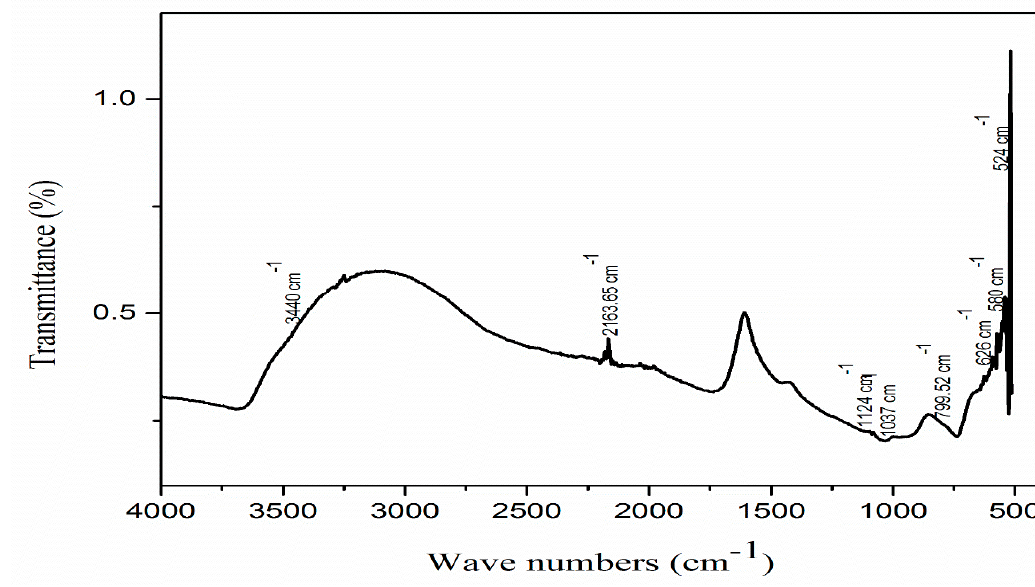
8 of 20 Figure 3. XRD patterns of MB-ZnO nanocomposites.